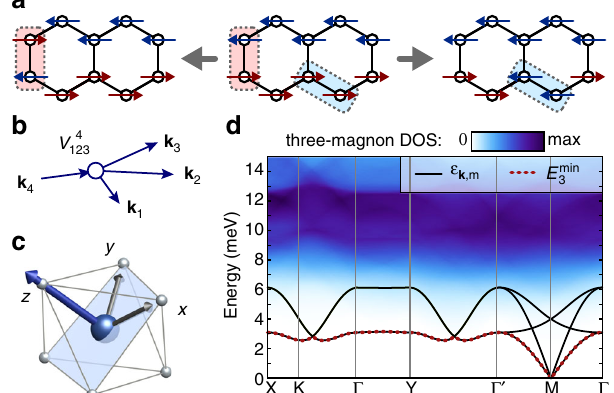
Fig. 4 Magnon decay channels for the nnHK model. a Local picture of quantum fl uctuations away from zigzag order. The energy cost for the left process vanishes on approaching the spin liquid J 1 = K 1 j j → 0. b Momentum space picture for the corresponding fourth-order decay process due to H 4 . c Ordered moment direction for Model 1 ( J 1 = − 2.2, K 1 = +7.4 meV), corresponding to the zigzag domain with ordering wavevector Q = Y. d LSWT dispersions ϵ k ; m , and three-magnon density of states (DOS) for Model 1 for the same zigzag domain as c . The dashed line indicates the (cid:4) (cid:5) bottom of the three-magnon continuum E min , which is coincident with the 3 lowest magnon